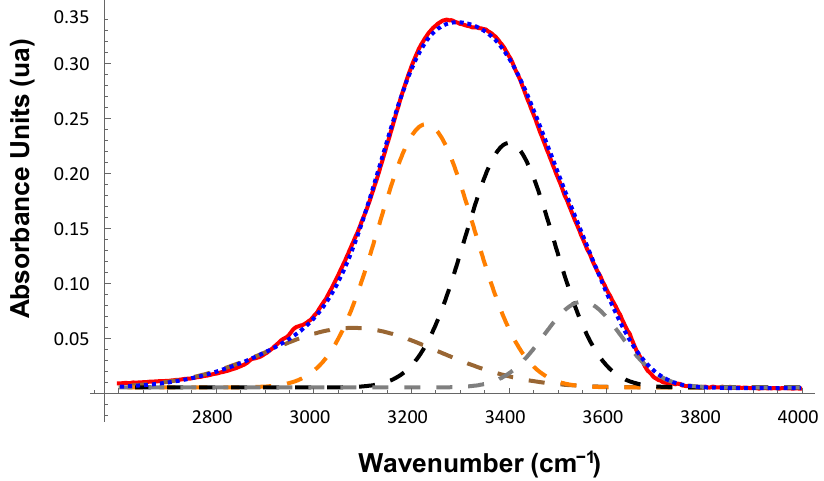
Figure 1. Examples of the ATR-FTIR spectra of OH-stretch band in the solvent for 250 mg/mL β -lactoglobulin A in 0.15 M NaCl in 0.01 M Na-phosphate buffer, pH 7.4 (PBS). The blue dotted line is the measured absorption spectrum, and the red envelope is the best fit of the sum of our four Gaussian components (dashed lines at positions (3080 cm − 1 (dark orange), 3230 cm − 1 (orange), 3400 cm − 1 (black), and 3550 cm − 1 (gray)). Experimental data and fit are visually almost indistinguishable. Estimates of the relative contributions of the Gaussian components I (3080 cm − 1 ), component II (3230 cm − 1 ), component III (3400 cm − 1 ), and component IV (3550 cm − 1 ) for all